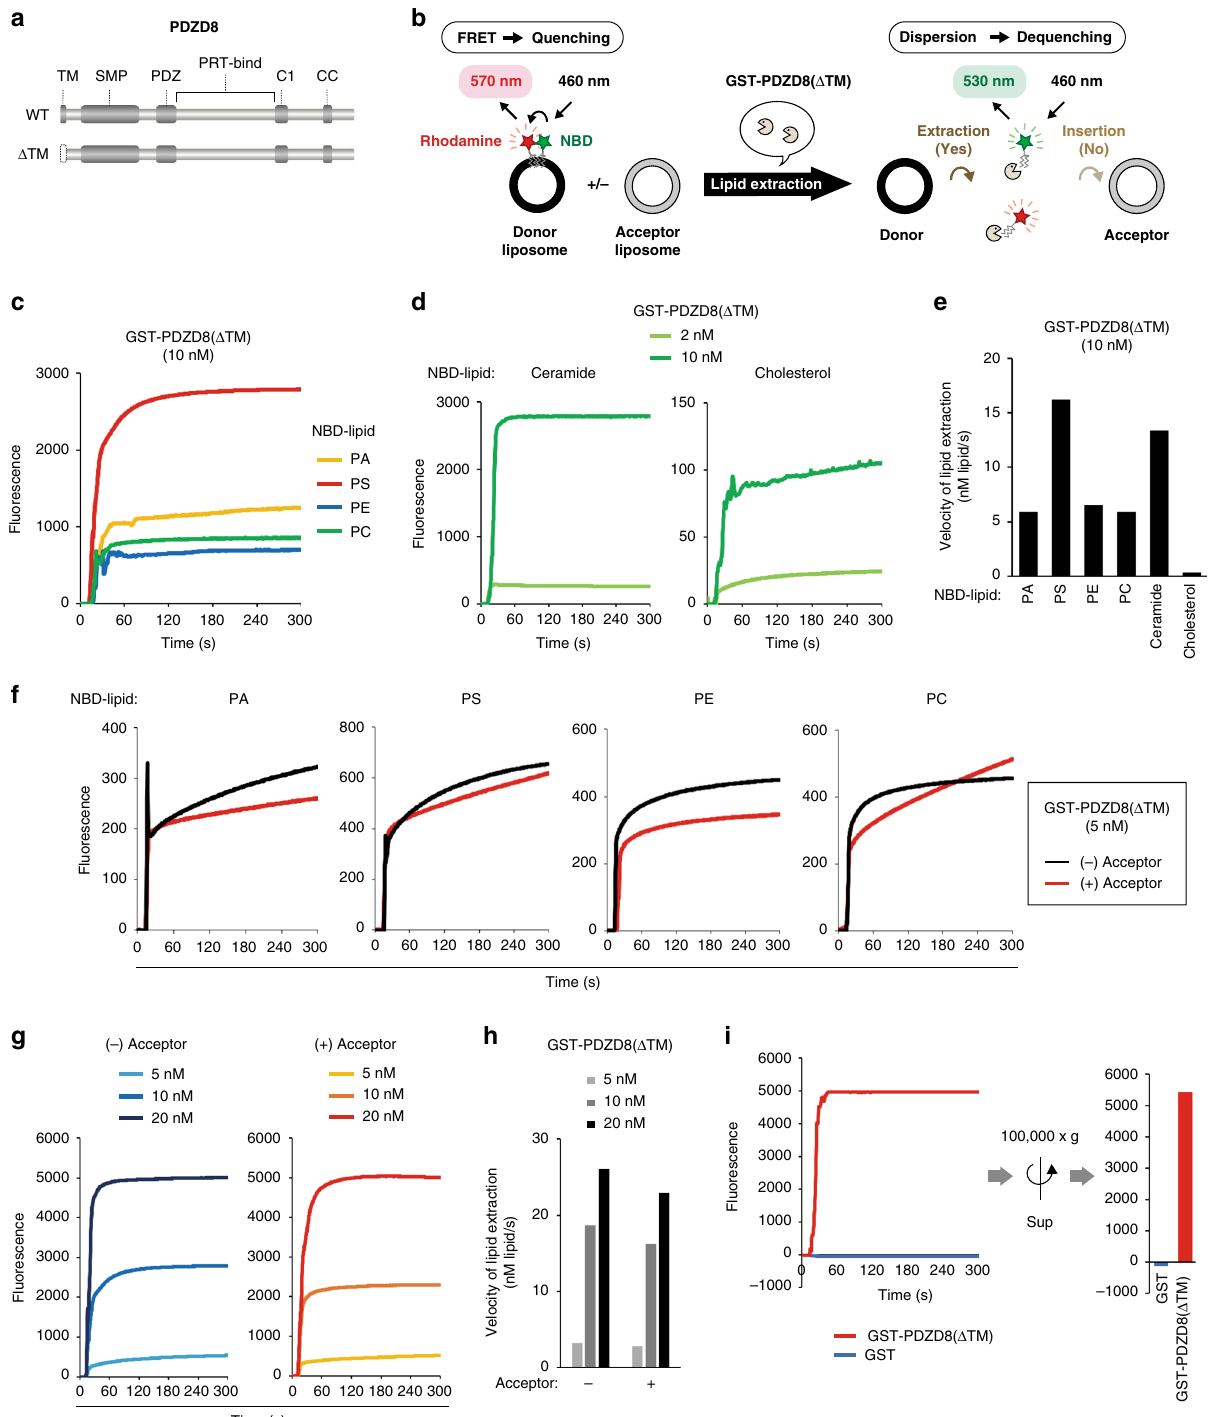
Fig. 3 Lipid extraction activity of PDZD8. a Domain structure of mouse PDZD8(WT) and PDZD8( Δ TM). b Schematic representation of the liposome- FRET assay. c Phospholipid (PA, PS, PE, and PC) extraction activities of GST-PDZD8( Δ TM). d Ceramide (left) or cholesterol (right) extraction activity of GST-PDZD8( Δ TM). e Initial velocity of lipid extraction by GST-PDZD8( Δ TM) measured in c and d ). f Phospholipid extraction activities of GST-PDZD8 ( Δ TM) with PA, PS, PE, and PC in the absence ( − ) or presence ( + ) of acceptor liposomes. g Concentration dependence for lipid extraction activity of GST- PDZD8( Δ TM) with PS in the absence (left) or presence (right) of acceptor liposomes. h Initial velocity of lipid extraction by GST-PDZD8( Δ TM) measured in g . i Detection of lipid (PS) extracted by GST-PDZD8( Δ TM) in the supernatent (Sup) separated from liposomes in the pellet after ultracentrifugation of the reaction mixture at 300